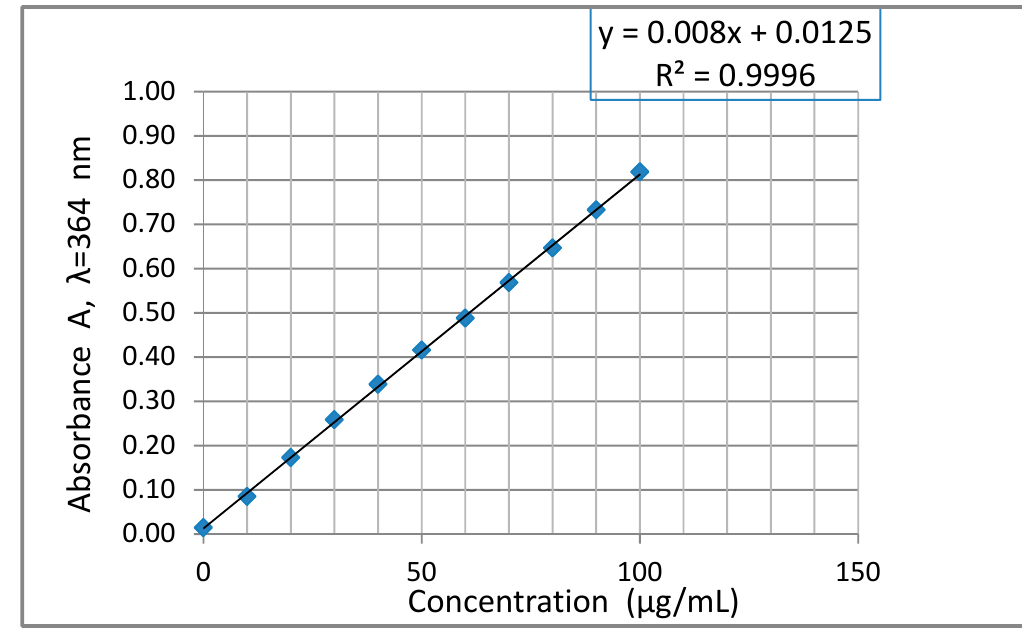
Figure 9. Dependence of absorbance A at λ = 364 nm as the function of 3-aminoflavone concentration in methanol. The quartz cuvette thickness l was 0.2 cm.